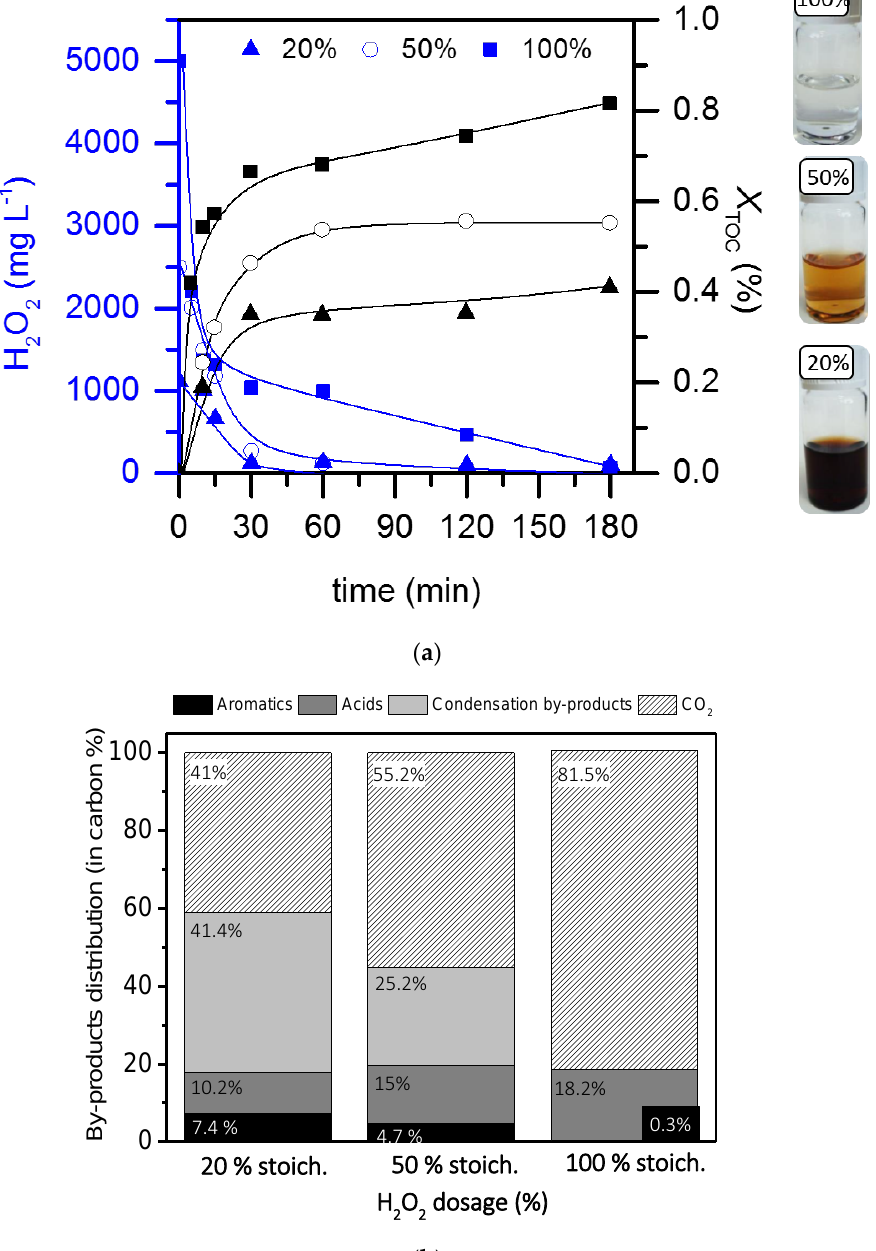
Figure 4. Effect of the H 2 O 2 dose on the H 2 O 2 consumption and mineralization ( a ) and by-product distribution at 3 h of reaction ( b ) upon phenol WPO-O 2 . Operating conditions: [Phenol] 0 = 1000 mg L −1 , P O 2 = 8 bar (92 N mL O 2 min -1 ), T = 127 °C and natural pH 0 . The inset images in ( a ) show the aspect of the liquid effluent after 3 h of reaction.